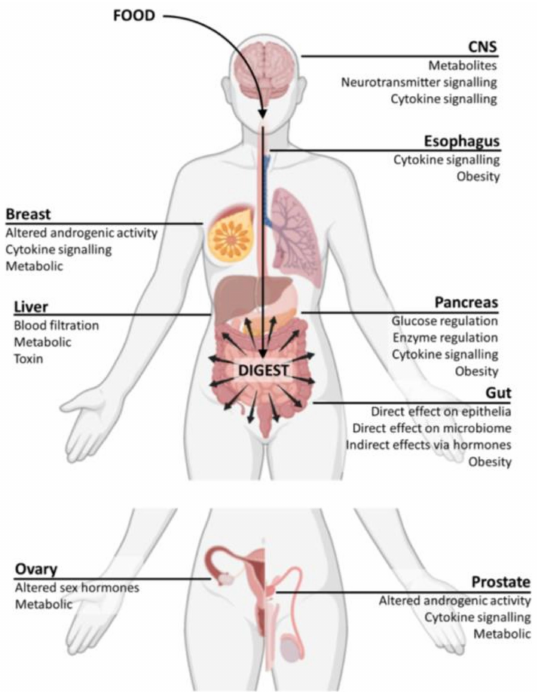
Figure 2. Potential effects of dietary factors on organs effected by cancer. Intake of dietary factors potentially affect bodily organs through direct filtration of blood or absorptive processes, or indirectly through regulation of metabolites absorbed by the gut, glycemic control (glucose, insulin, cholesterol), regulation of metabolic pathways, inflammatory response to systemic cytokine production, altered sex hormone activity, neurotransmitter metabolism, and response to chronic obesity, as